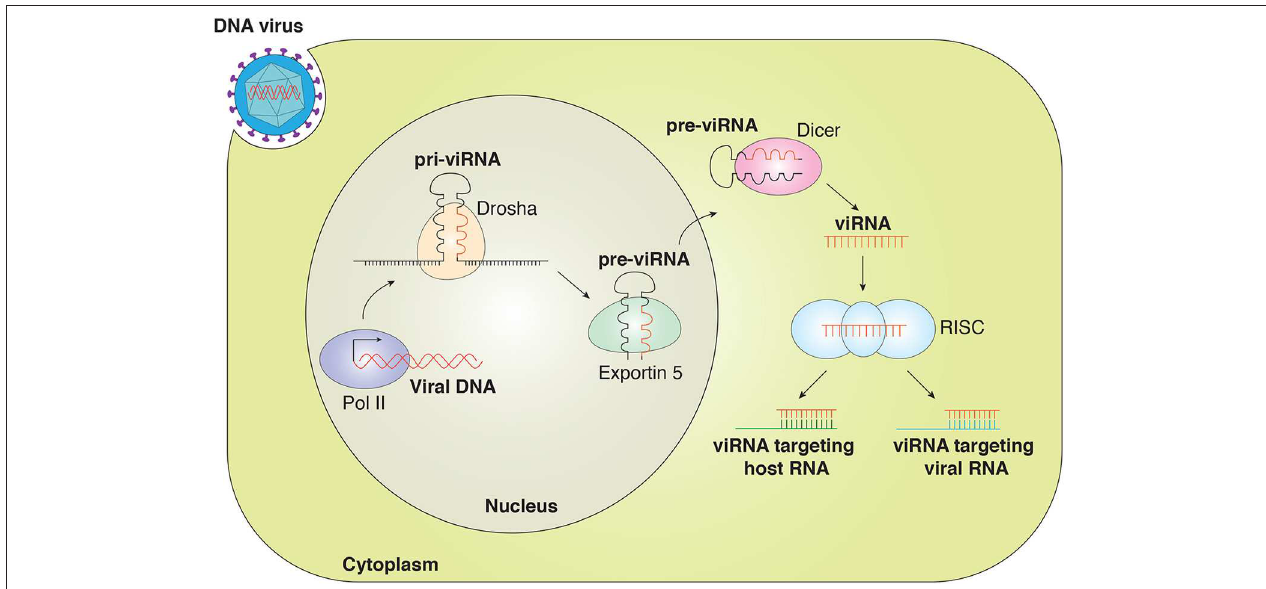
FIGURE 1 | Canonical viral miRNAs are transcribed as pri-v-miRNAs from the genome of DNA viruses in the nucleus. Cleavage of pri-v-miRNAs by Drosha results in pre-v-miRNA that is exported to the cytoplasm via Exportin 5. In the cytoplasm, pre-v-miRNAs undergo cleavage by Dicer to generate the mature v-miRNAs that are loaded in the multiprotein RISC complex to target the host and viral mRNA transcript. v-miRNAs (viRNA).